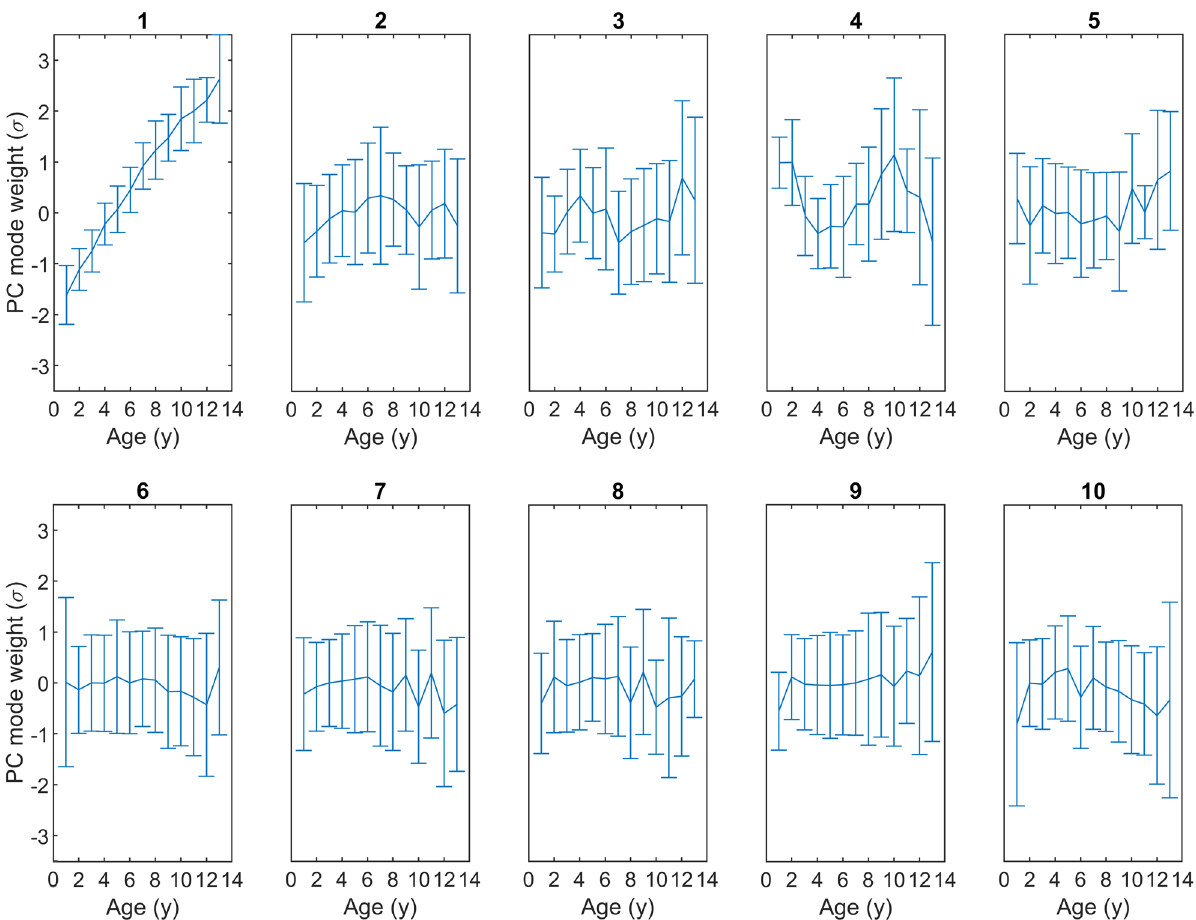
Figure 6. Principal component (PC) weight in standard deviations (vertical axis) plotted against dental age (horizontal axis) for PC modes 1–10.